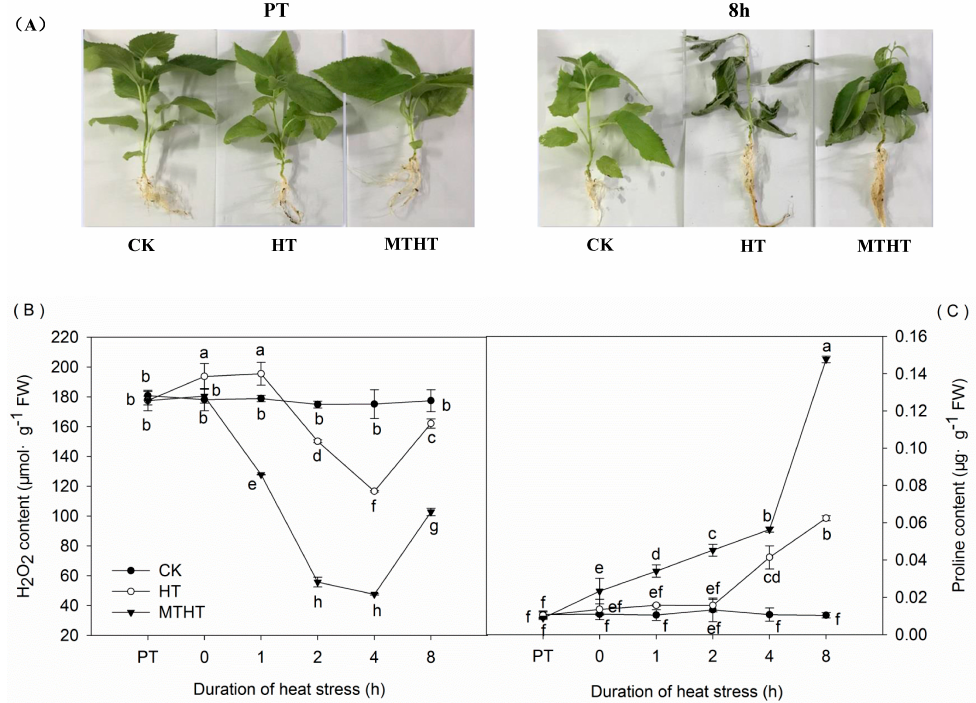
Figure 1. ( A ) Seedling morphology at PT (25 °C starting temperature) and after 8 h at 45 °C; ( B ) H 2 O 2 content in leaves under heat stress; ( C ) Proline content in leaves under heat stress. CK, control; HT, high temperature treatment (45 °C); melatonin-pretreated high-temperature (MTHT), high temperature with melatonin pre-treatment. Data are means of three biological replicates ( n = 3). Lowercase letters indicate significant differences ( p < 0.05).